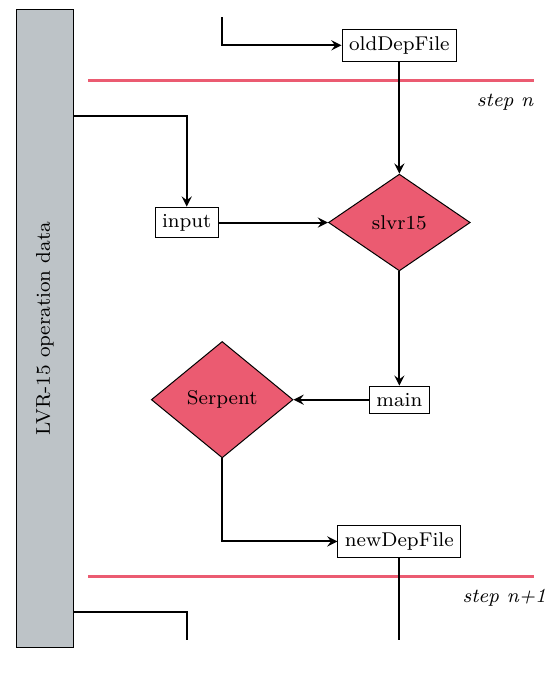
Figure 4. Scheme of the computational